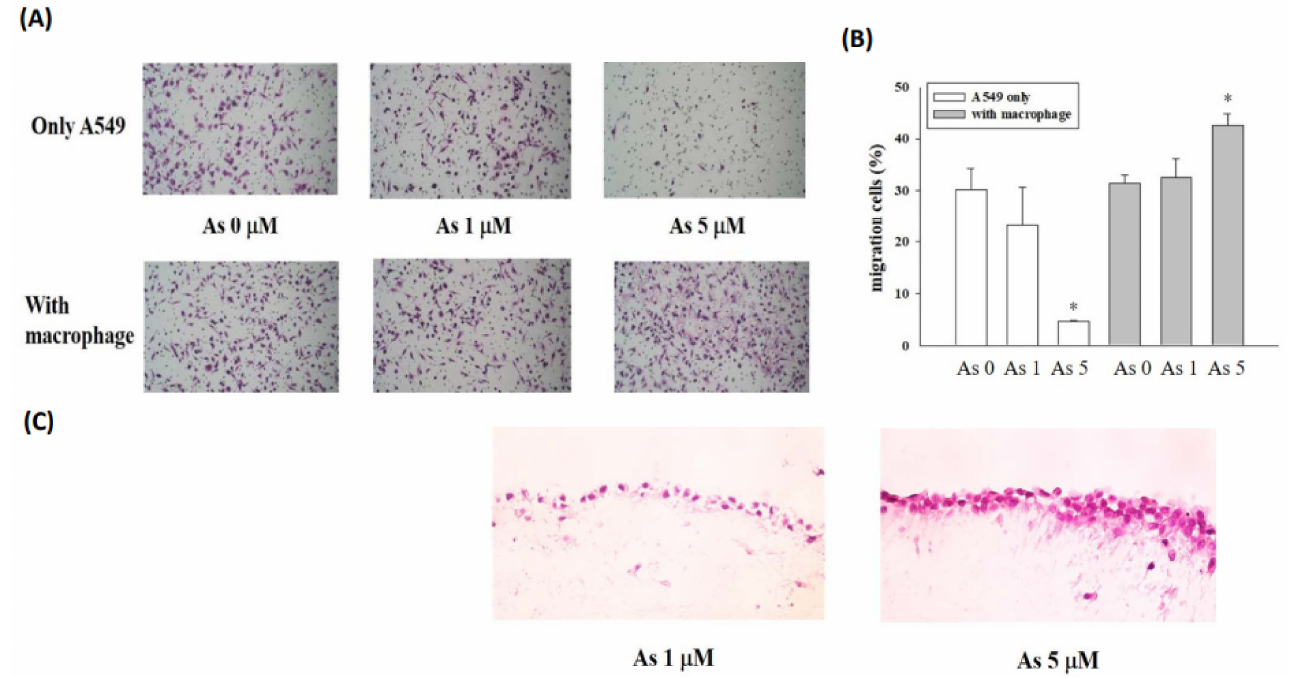
Figure 5. Arsenic-treated M1 macrophages promoted epithelial cell migration and invasion. ( A ) THP- 1-derived M1 macrophages were treated with 5 µ M arsenic and co-cultured with A549 lung cancer cells in trans-wells for 24 h. The migration of A549 cells through the trans-well membrane was observed upon Giemsa staining (40 × under an optical mi-croscope). ( B ) The number of migrated cells was analyzed using ImageJ software. * p < 0.05, arse-nic-treated vs. untreated (N = 3). ( C ) A549 cells were cultured on a collagen gel (2 mg/mL) and co-cultured with THP-1-derived M1 macrophages in trans-wells, with or without 1 or 5 µ M arse-nic. After 24 h of co-culture, the collagen gels with the A549 cells were fixed, and 5 µ M parafilm sections were prepared. After H&E staining, the